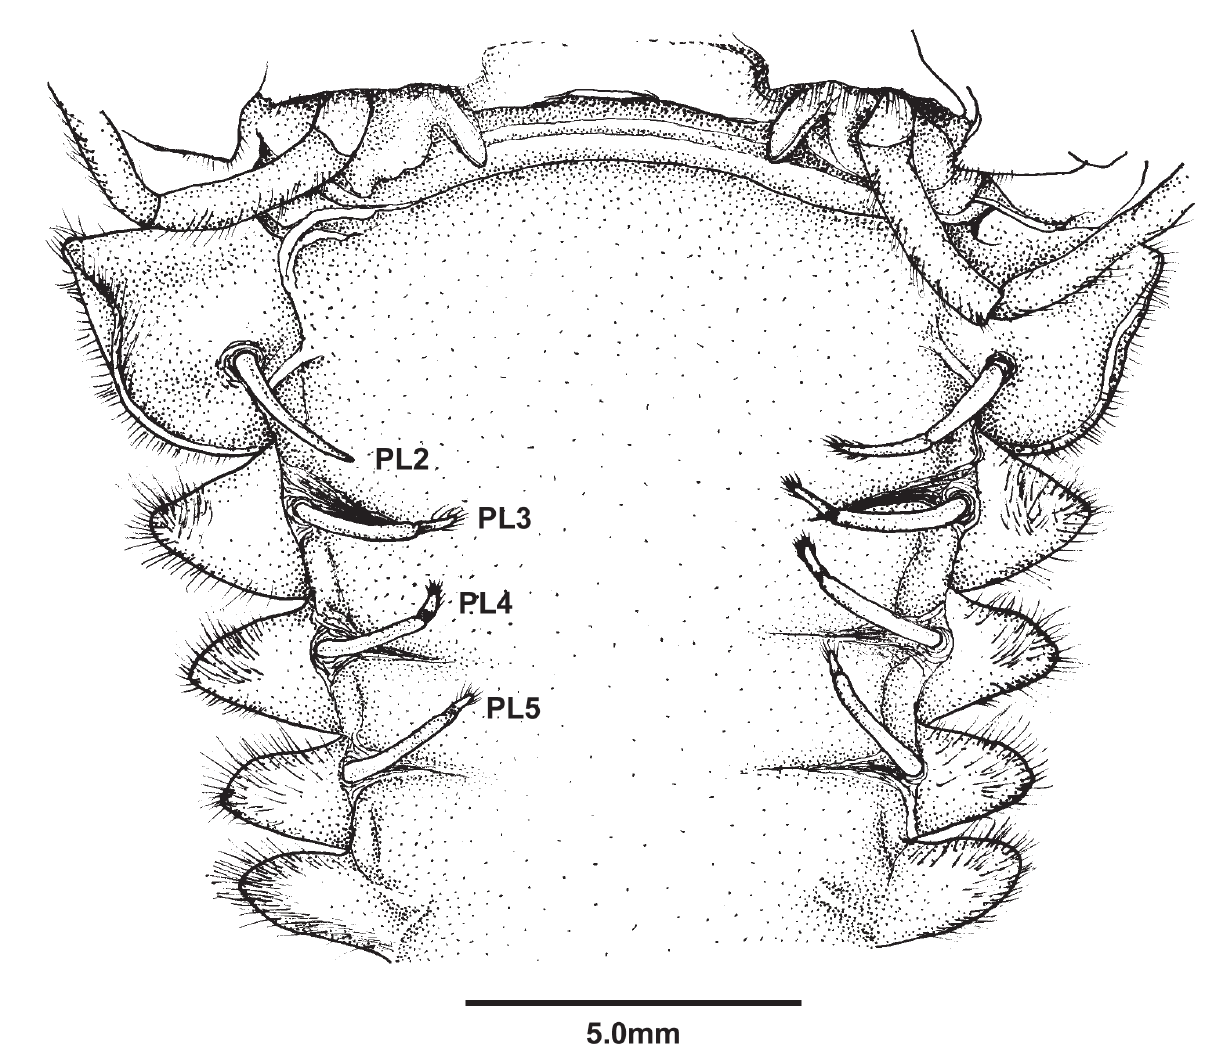
Figure 11. Aegla charon n. sp., male paratype (CL 20.57 mm; CLR 23.95 mm) (MZUSP 35194), ventral view of pleon after being streched out, showing pairs of pleopods (PL) 2 through 5. Except for one of the PL2, which is depicted as 1-segmented, all other pleopods are 2-segmented and bearing few long setae